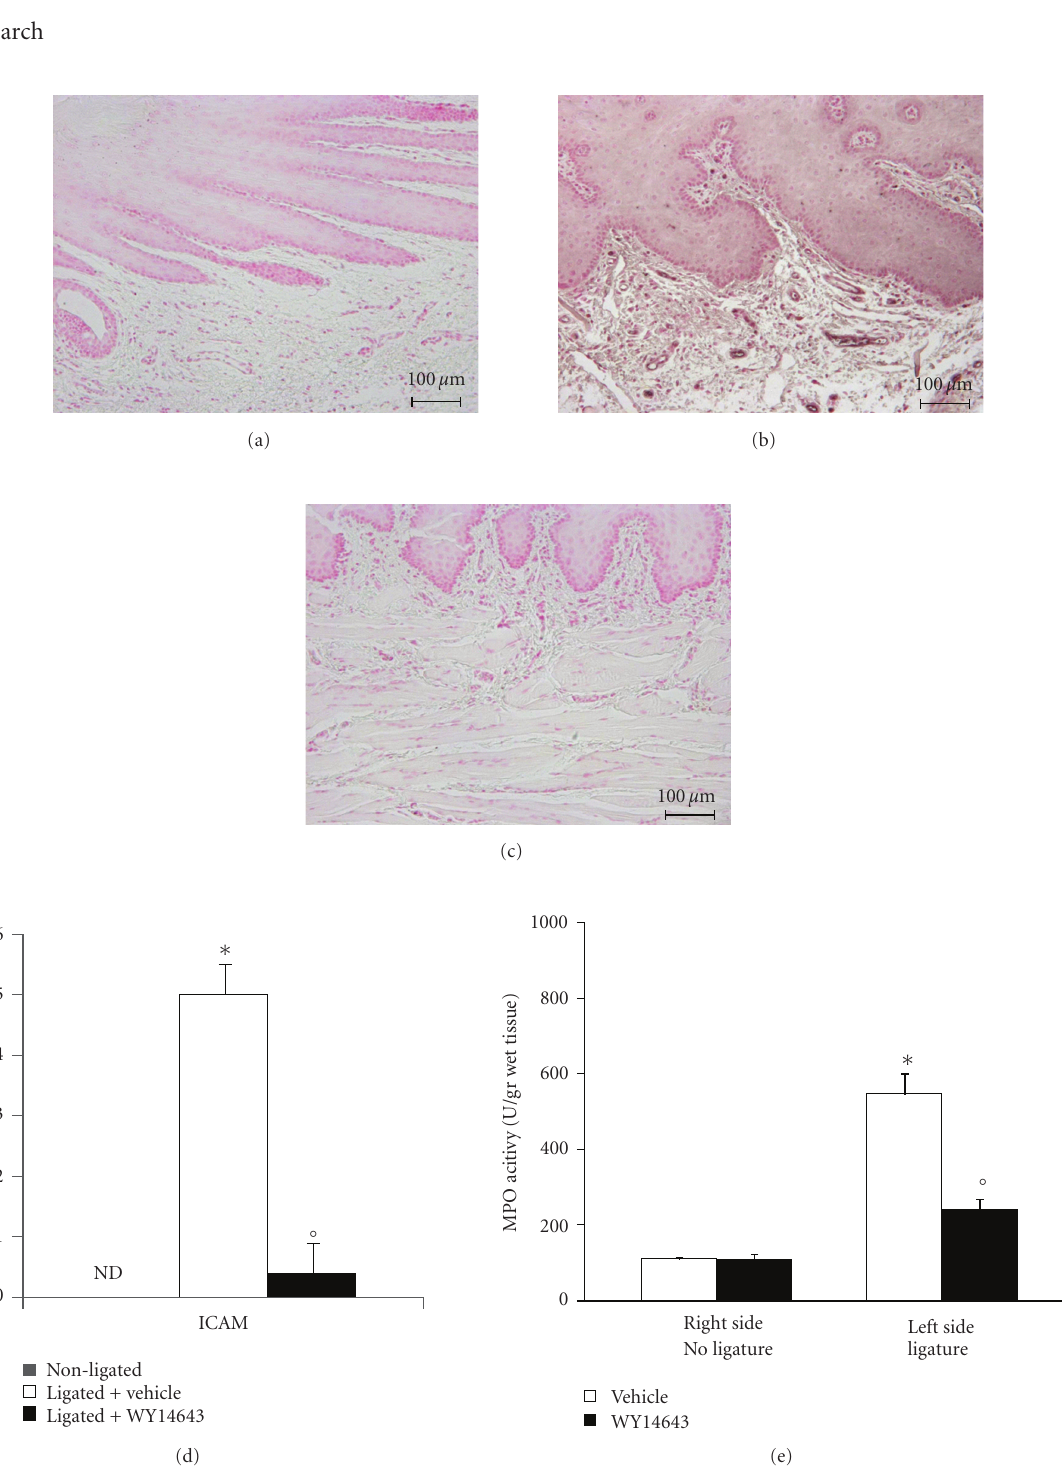
Figure 4: E ff ects of WY14643 on the expression of ICAM-1 and neutrophils infiltration. Immunohistochemical analysis of gingivomucosal tissues from the contra lateral side obtained from vehicle-treated rats did not reveal any immunoreactivity for ICAM-1. (a) Positive staining for ICAM-1 was found in the gingivomucosal tissues from ligature operated rats. (b) In contrast, a positive staining for ICAM- 1 was significantly attenuated by the treatment with WY14643. (c) Moreover myeloperoxidase activity (e) in gingivomucosal tissue was significantly increased by ligature compared to the contra lateral side obtained from vehicle-treated rats. WY14643 significantly reduced myeloperoxidase activity levels. Figure is representative of at least 3 experiments performed on di ff erent experimental days. Densitometry analysis of immunocytochemistry photographs; (d) n = 5 photos from each samples collected from all rats in each experimental group) for ICAM-1 from gingivomucosal tissue was assessed. The assay was carried out by using Optilab Graftek software on a Macintosh personal computer (CPU G3-266). Densitometry data are expressed as % of total tissue area. Data are means of mean ± s.e.m. from n = 10 rats for each group. ∗ P < . 01 versus nonligated. ◦ P < . 01 versus